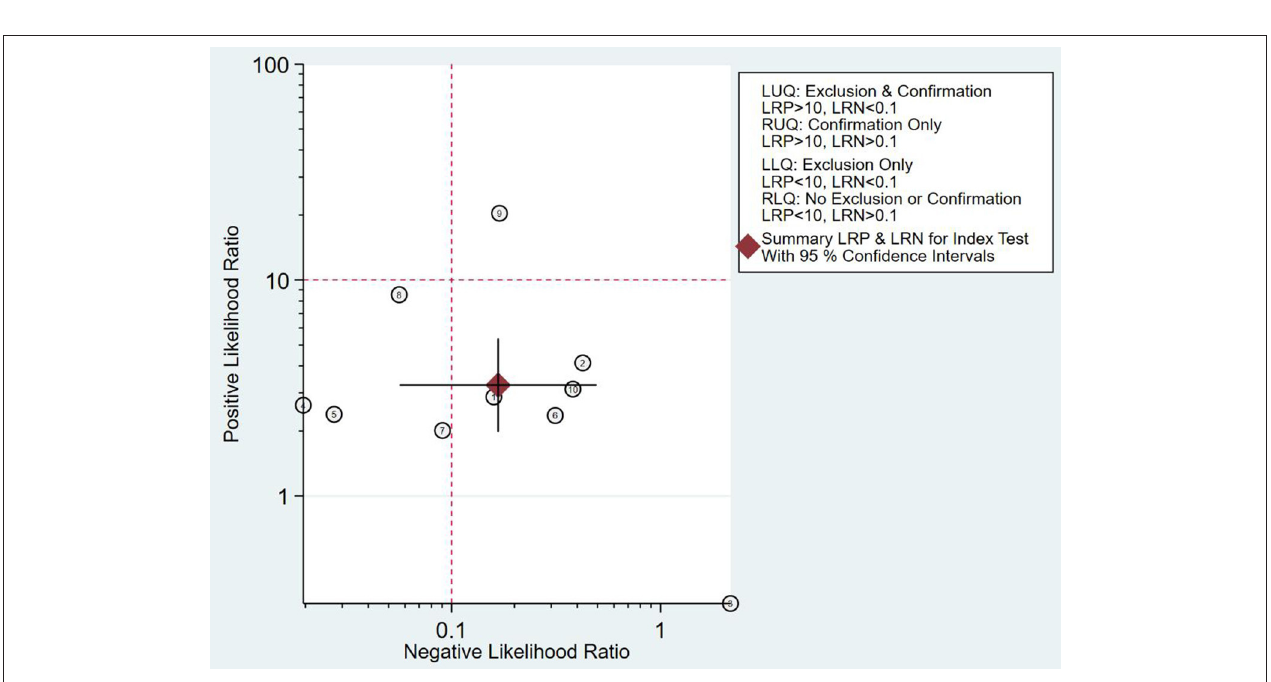
FIGURE 6 | Sensitivity analysis of studies. (A) Goodness-of-fit, (B) bivariate normality, (C) influence analysis, and (D) outlier detection.